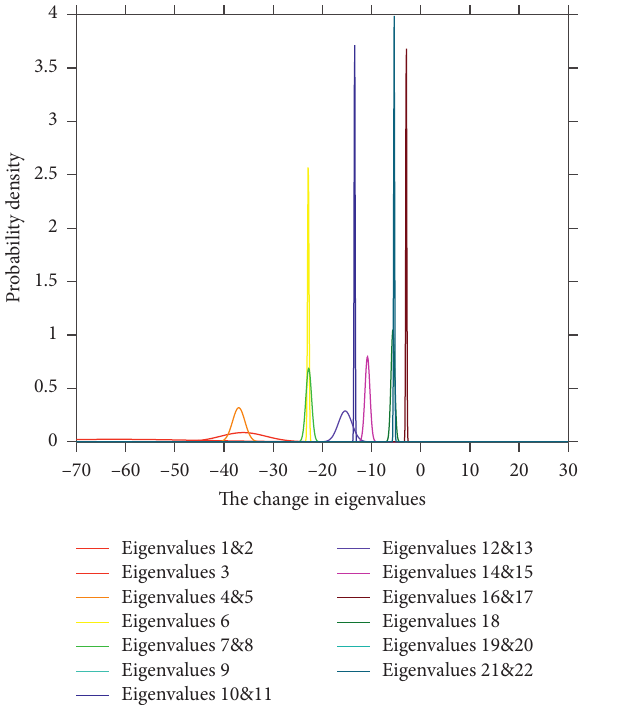
Figure 4: Probability distribution of the eigenvalue. Table 2: SG and GCV at different nodes.